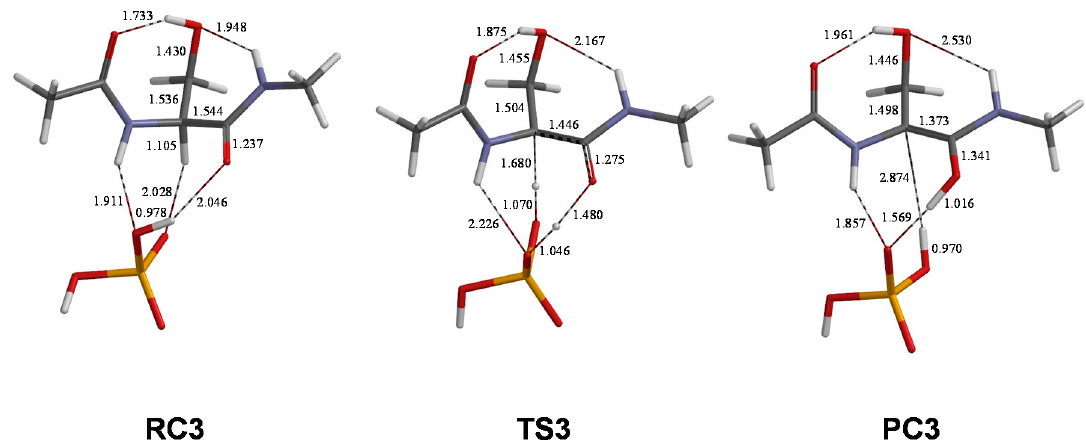
Figure 6. The geometries of RC3 (reactant complex of pathway 3), TS3 (transition state of pathway 3), and PC3 (product complex of pathway 3). Selected interatomic distances are shown in Å. Grey: carbon; white: hydrogen; blue: nitrogen; red: oxygen; orange: phosphorus.